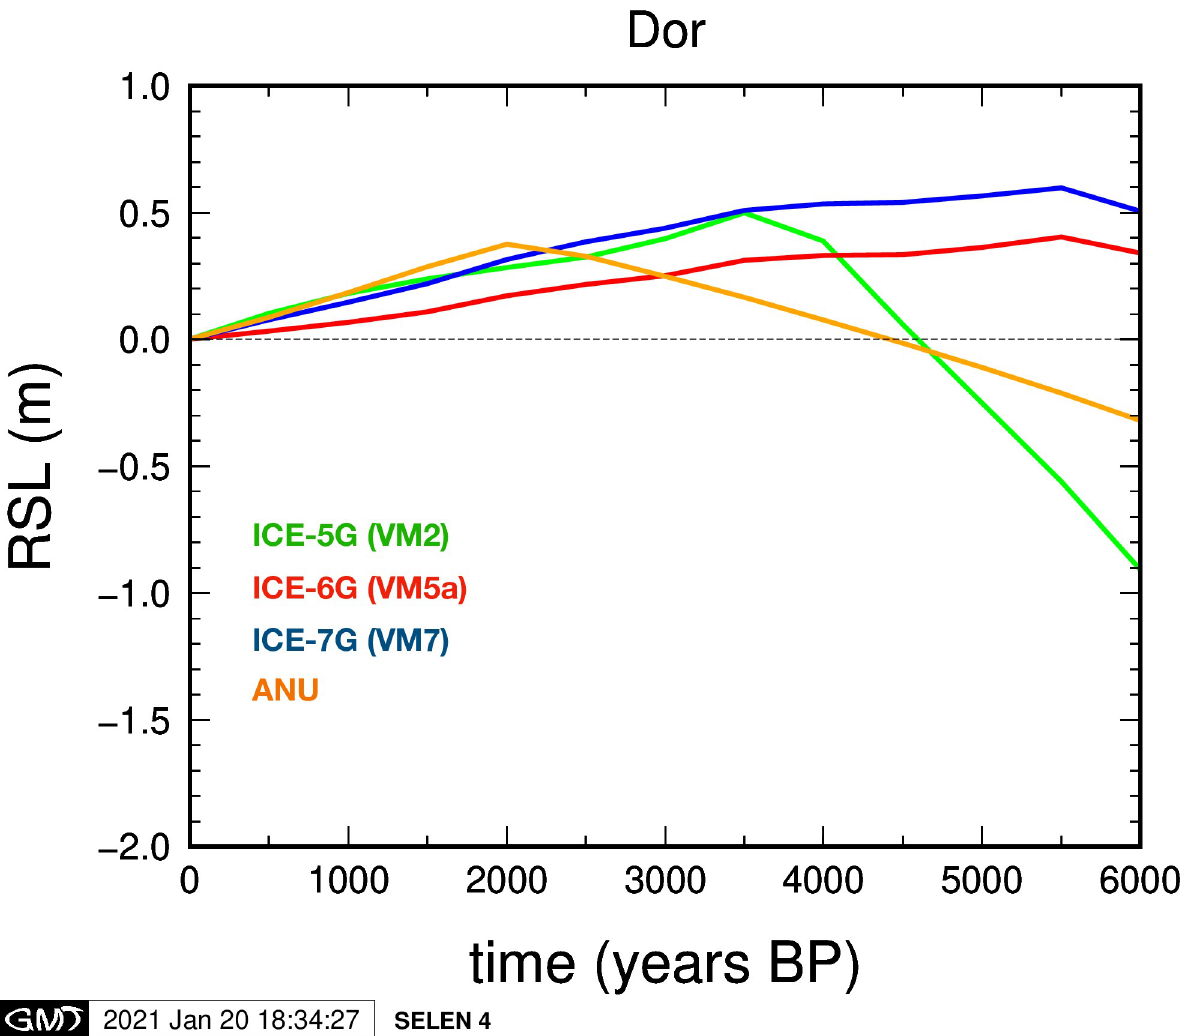
Fig 6. Synthetic RSL reconstructions at Dor obtained with the SELEN4 SLE solver. Models ICE-5G(VM2a), ICE-6G (VM5a), ICE-7G (VM7) and ANU have been considered, as summarized in the main text. All the four GIA models have been implemented into the SELEN4